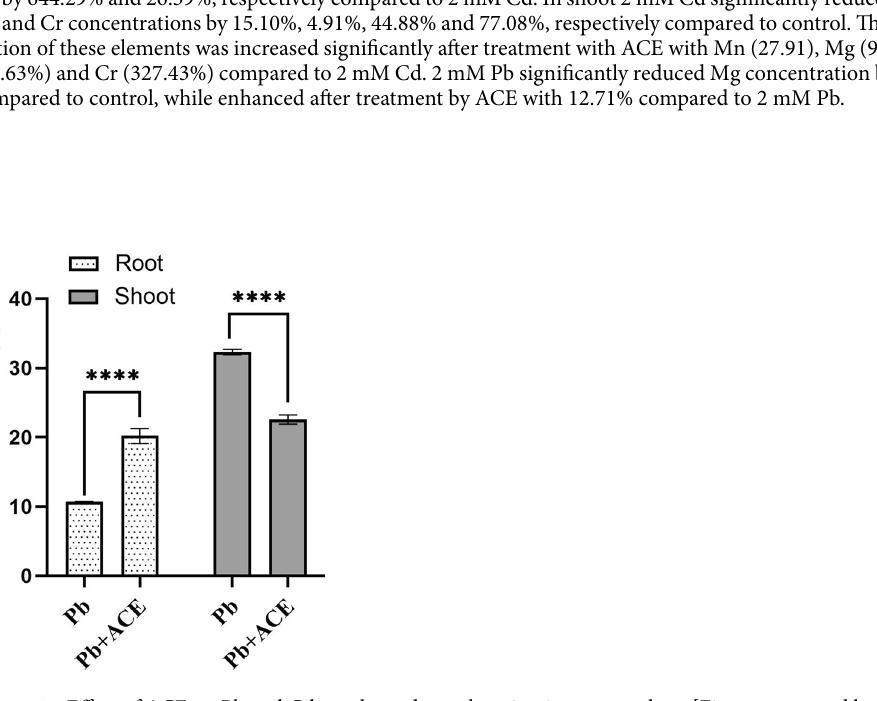
Figure 5. Effect of ACE on Pb and Cd uptake and translocation in tomato plant. [Figure generated by GraphPad prism 9 software, while, “****” indicates statistical significance ( P = 0)].